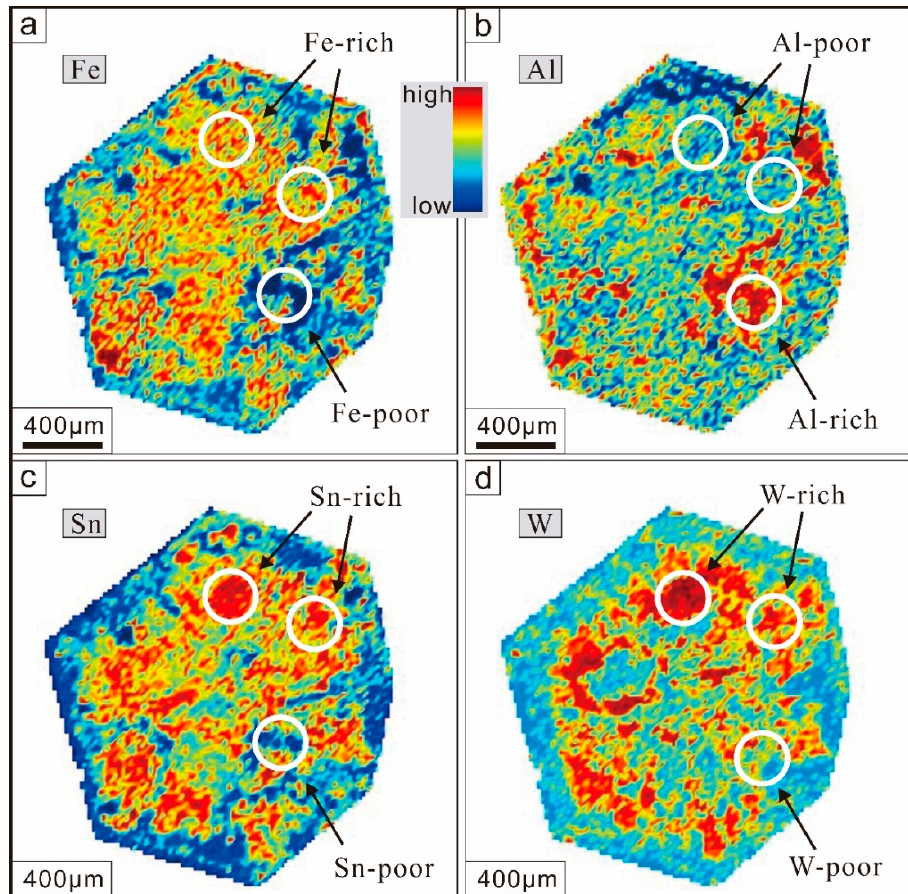
Figure 5. LA-ICP-MS element mapping results of ( a ) Fe, ( b ) Al, ( c ) Sn, and ( d ) W for a garnet crystal in Xianghualing. Table 1. Summary of the major element compositions (in wt %) of the Xianghualing garnet. Sample